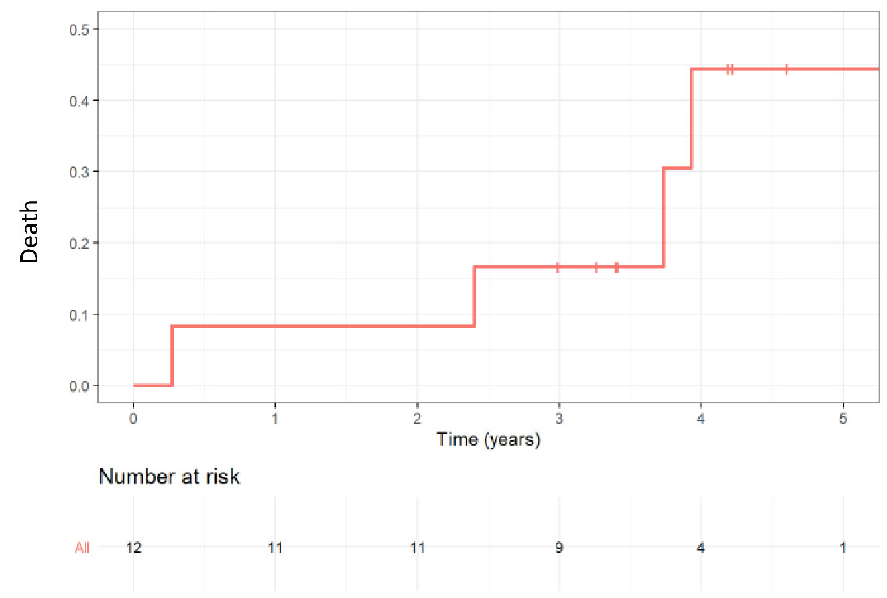
Figure 3. Kaplan–Meier mortality curve during follow ‐ up.